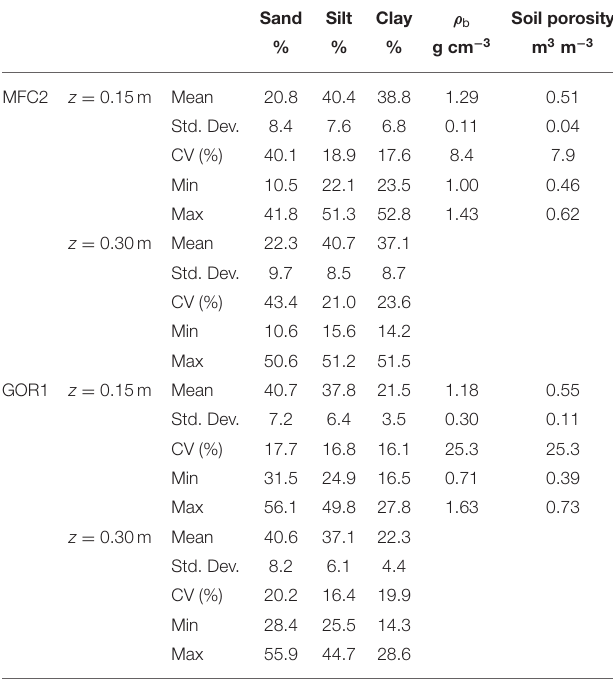
TABLE 1 | Descriptive statistics of sand, silt, and clay contents (in percent) at the two sampled soil depths (0.15 and 0.30m) and oven-dry soil bulk density ( ρ b ) with corresponding soil porosity at the soil depth of 0.15m in the 20 SoilNet units for both MFC2 and GOR1 sub-catchments. Sand Silt Clay ρ b Soil